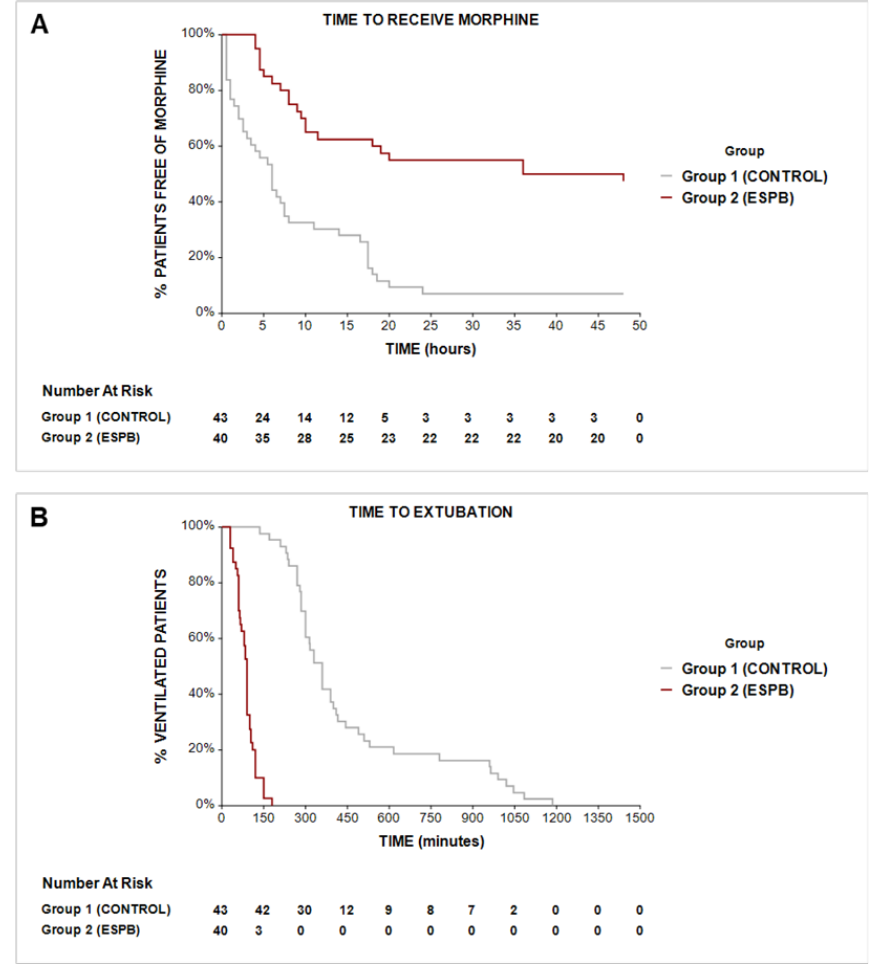
Figure 4. Kaplan–Meier curve to compare the time required to receive morphine after ICU admission ( A ) and the time required to extubate the patient ( B ). The Cox proportional hazard ratio for postoperative morphine in the ESPB-to-Control group was 0.3 (HR: 0.30; 95% CI: 0.18 – 0.50; p < 0.001). The Cox proportional hazard ratio for extubation in the ESPB-to-Control group was 5.24 (HR: 5.24; 95% CI: 2.87 – 9.57; p < 0.001). Abbreviations: ESPB, erector spinae plane block.